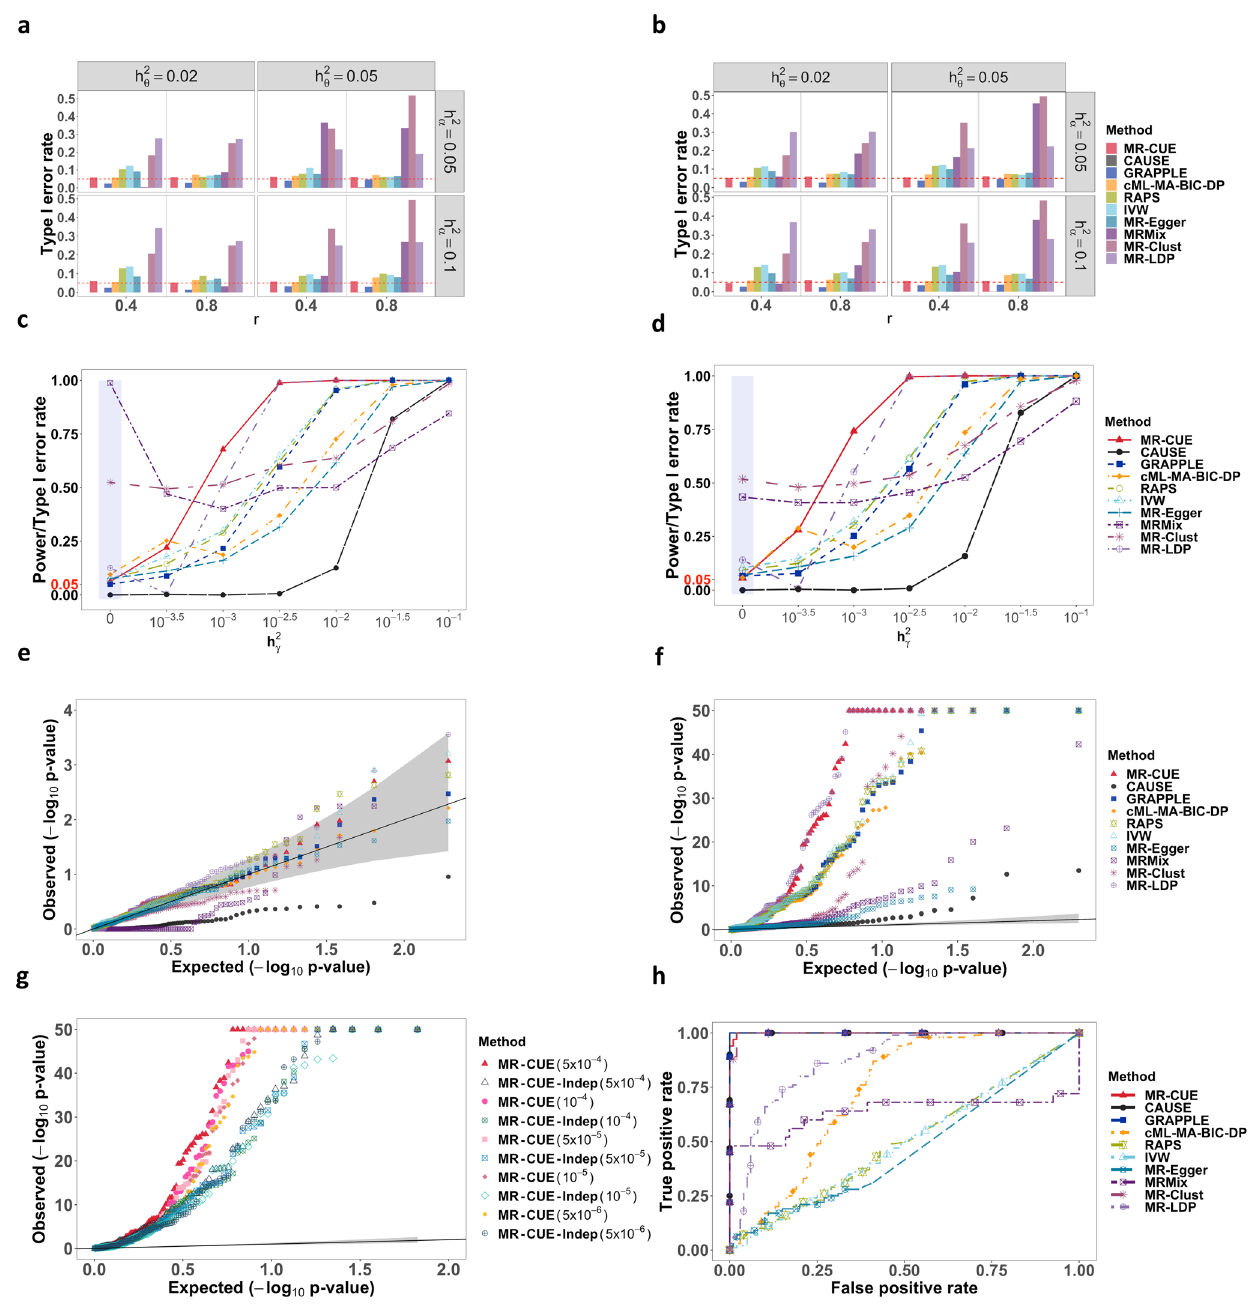
Fig. 2 | Comparison of MR-CUE and other MR methods in simulation studies. a , b TypeIerrorratesforMR-CUEandothermethodsundercombinatorialsettings for h 2 θ and h 2 α with ρ αγ =0.2 and p =1000 for single and multiple confounders, respectively. c , d PowersforMR-CUEandothermethodsunderthesetting: h 2 θ =0 : 1, h 2 α =0 : 05, p =1000, r =0.4 and ρ αγ =0.2 for single and multiple confounders, respectively. e QQ plots of (cid:2) log 10 ( p -values) for all methods under the null from